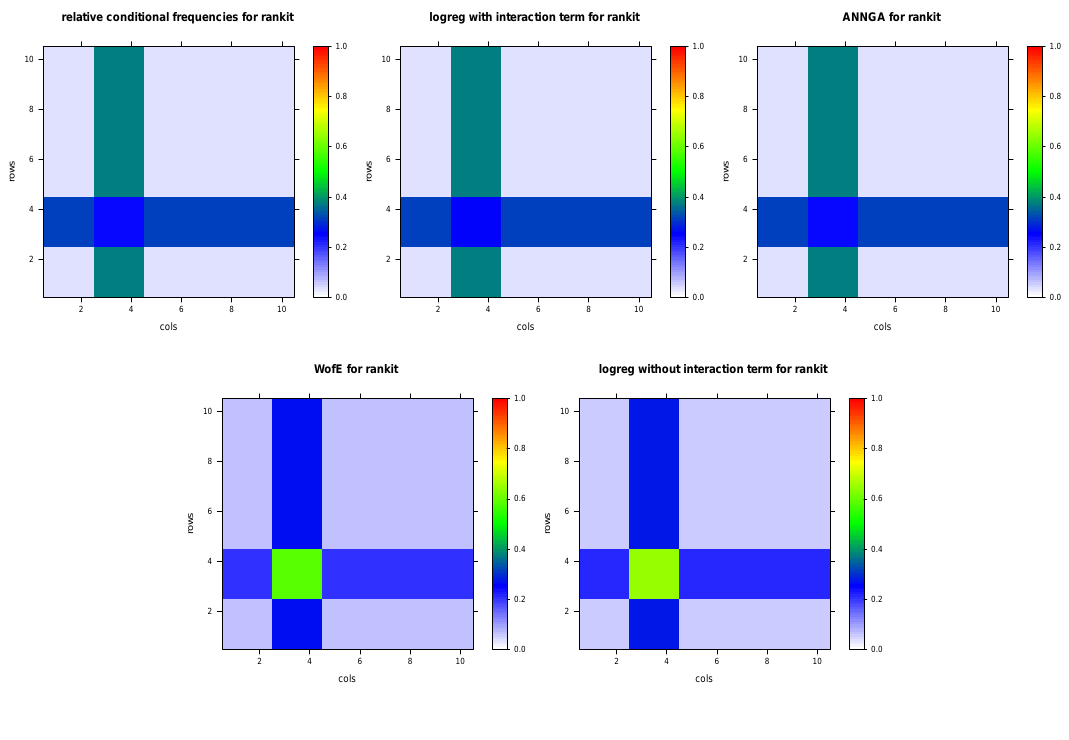
Figure 2. Spatial distribution of predicted conditional probabilities (cid:98) P ( T = 1 | B for the training dataset RANKIT according to: elementary estimation ( top left ); logistic regression with interaction term ( top center ); artificial neural net ANNGA of R ( top right ); weights-of-evidence ( bottom left ); logistic regression without interaction ( bottom right ).